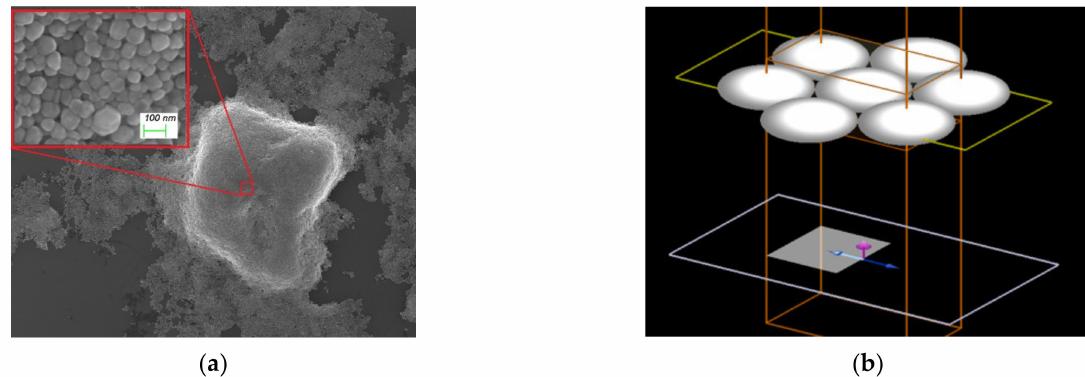
Figure 6. Microstructure of Ag NPs of SERS device. ( a ) Ag NPs on Si observed under scanning electron microscope, and ( b ) Model for FDTD simulation of single layer hexagonal stacked Ag